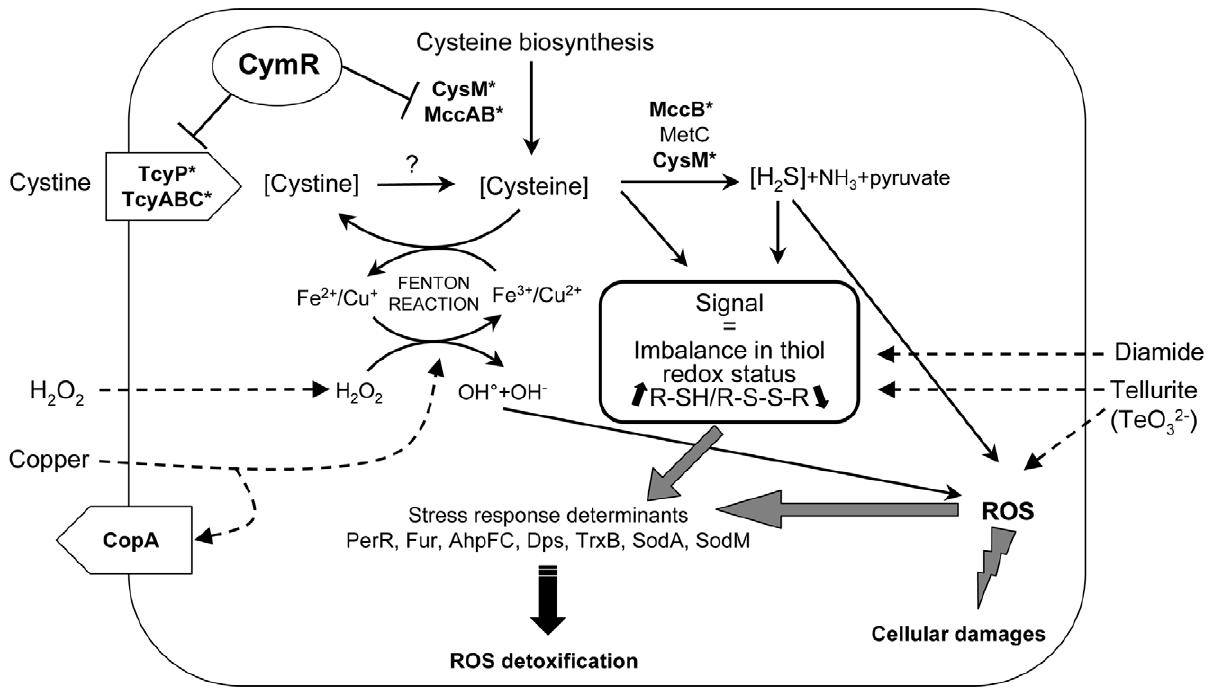
Figure 6. Proposed model for the role of CymR in the stress response in S.aureus . In the absence of CymR, the derepression of genes involved in pathways leading to cystine/cysteine uptake (e.g. tcyP , tcyABC encoding cystine transporters) and biosynthesis (e.g. cysM encoding OAS thiol-lyase and mccAB encoding homocysteine to cysteine conversion enzymes) leads to increased intracellular cysteine levels. High amounts of cysteine promote oxidative DNA damage by driving the Fenton reaction. Iron and copper are both capable of catalyzing the formation of hydroxyl radicals from H 2 O 2 . Cysteine may be catabolized into hydrogen sulfide (H 2 S), pyruvate and ammonia (NH 3 ) by cysteine desulfhydrases (MccB, MetC, CysM). High H 2 S levels may also induce oxidative stress by the formation of reactive oxygen species (ROS). The altered stress response may be explained by an imbalance in thiol redox status induced by cymR inactivation. Different stress response systems including PerR regulon members (AhpFC, Dps, TrxB, PerR and Fur), superoxide dismutases (SodA, SodM) and a copper efflux system (CopA) may recognize a common stress signal in the D cymR mutant. This signal may either be an increase in intracellular cysteine pools or changes in levels of other cysteine-related compounds. Tellurite, copper, H 2 O 2 and diamide can cause imbalance in the thiol status of the cytoplasm and oxidative stress. A question mark indicates a step, which remains to be characterized. Asterisks indicate directly controlled CymR target